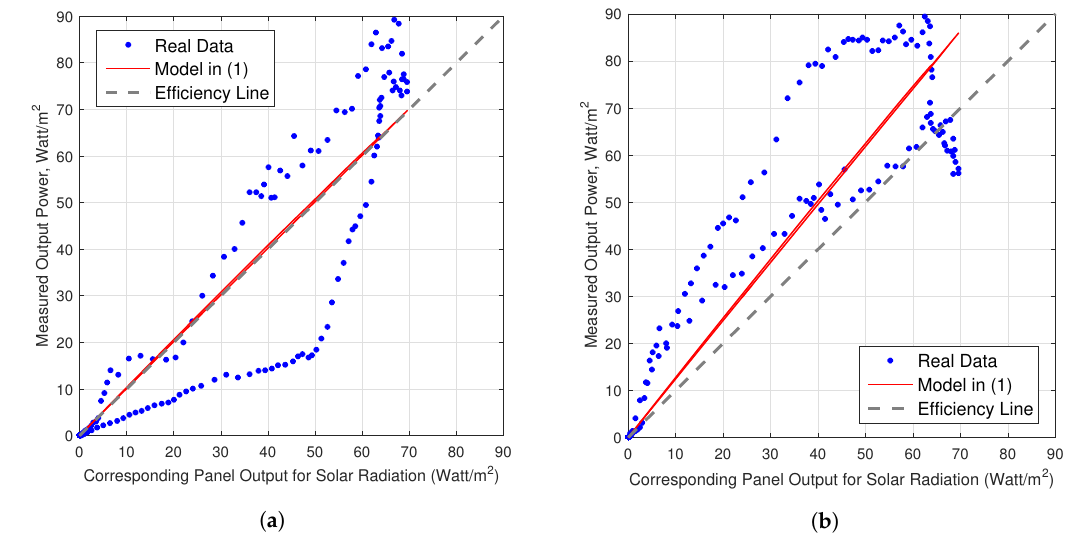
Figure 7. Measured output power value and corresponding panel output for solar radiation model in (1): ( a ) Fixed system; ( b ) Sun-tracking